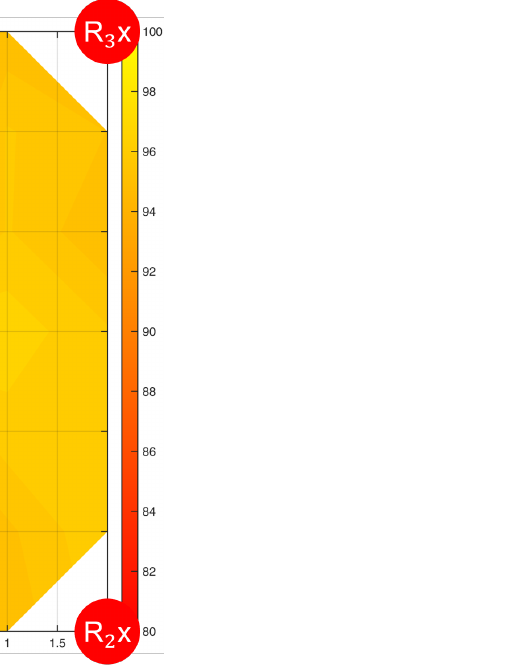
Figure 14. Accuracy contour (%) in detecting the duration of resting tremor by multiple WiFi